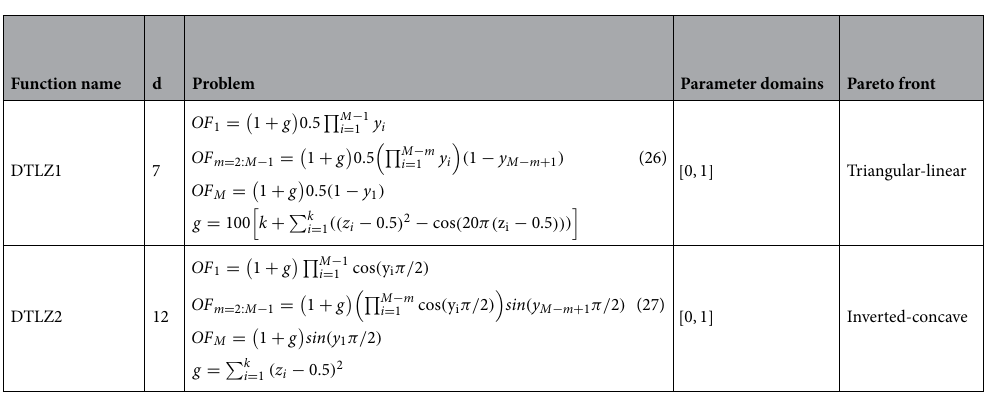
Table 2. DTLZ1 and DTLZ2 tri-objective test function 39